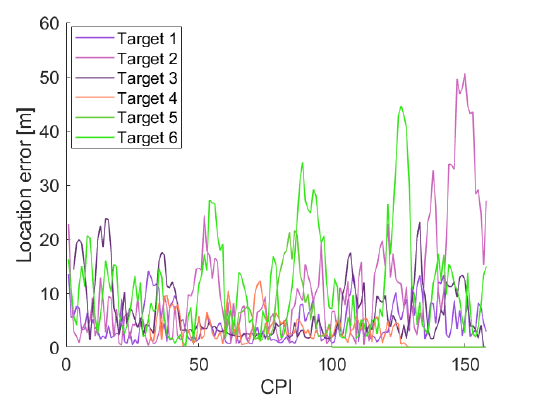
Figure 9. Localization error in the simulated